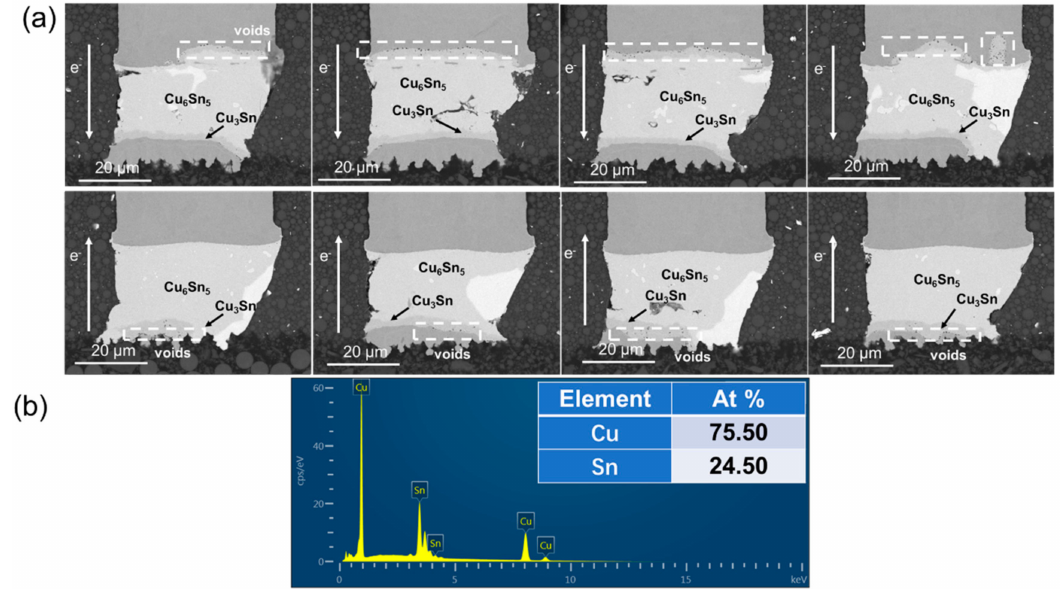
Figure 5. Microstructures of copper pillars full of IMCs after current stressing at 1.5 × 10 4 A/cm 2 at